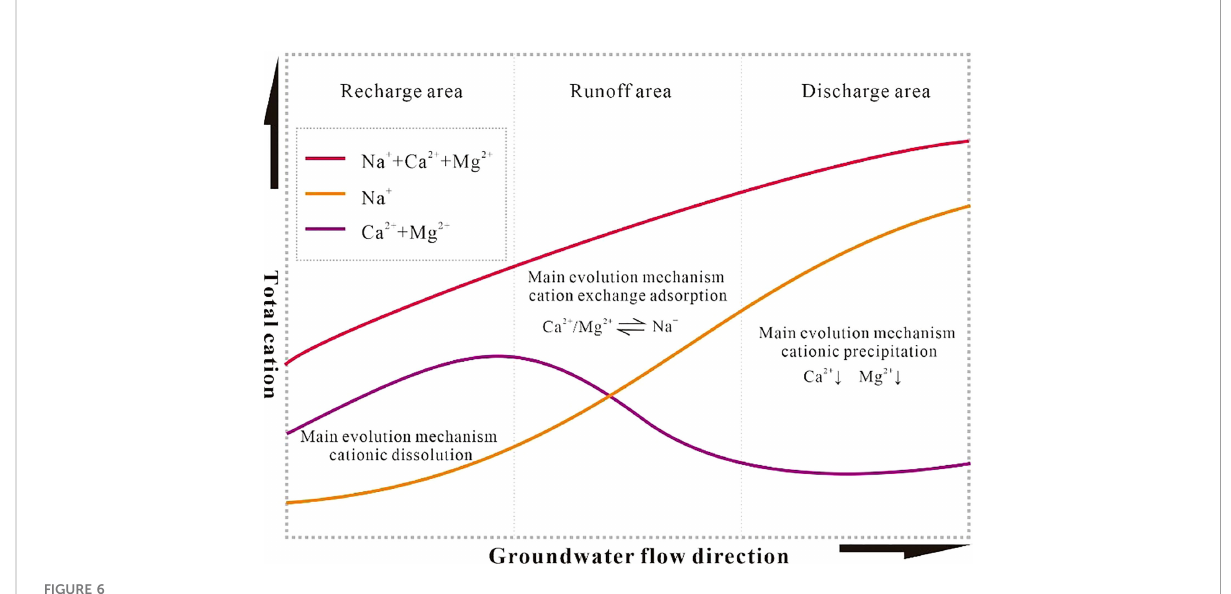
FIGURE 6 Schematic diagram of cation evolution in groundwater fl ow